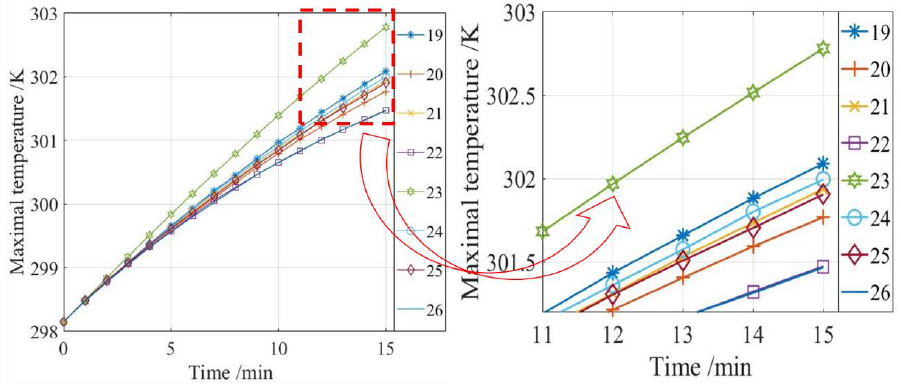
Figure 18. The maximal temperature of schemes for the battery pack with a single inlet and single outlet over time.